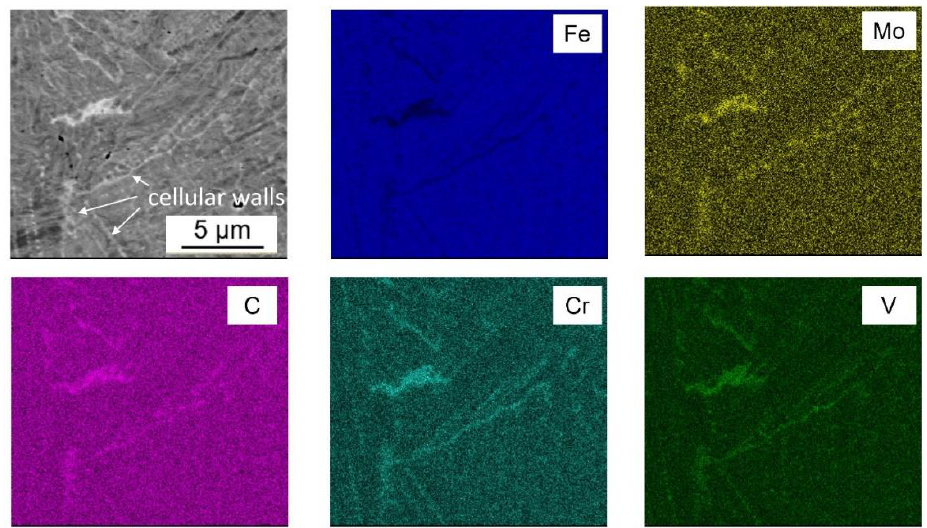
Figure 7. Backscattered-Electron ( BSE) micrograph of the as-built sample with 250 °C preheating temperature and corresponding elemental Energy Dispersive Spectroscopy (EDS) mapping.